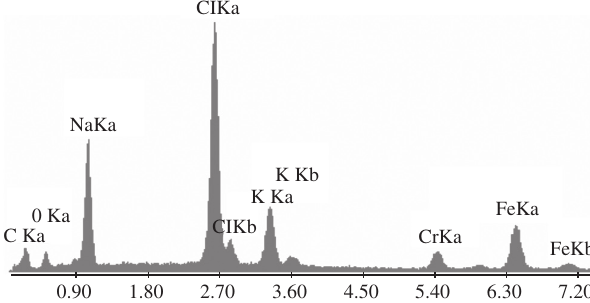
Figure 4. Chemical composition of cubic precipted on surface.